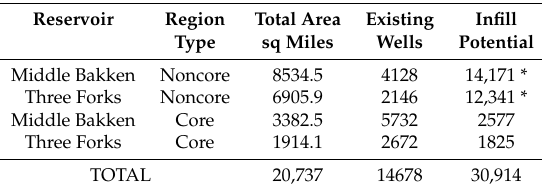
Table 3. Infill potential for Bakken region.